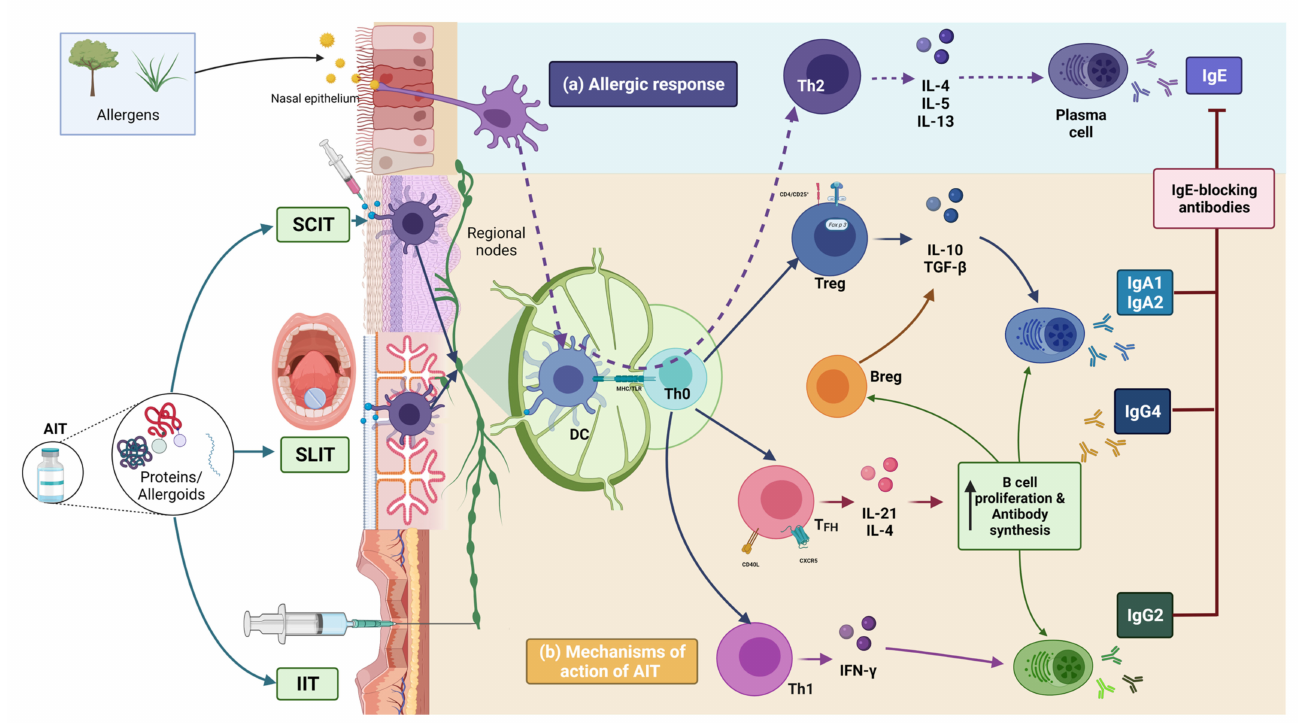
Figure 2. Mechanism of allergen-specific immunotherapy. ( a ) The allergic response begins with the allergen being endocytosed by the dendritic cells of the airway epithelium (DC). Subsequently, DC goes to local secondary lymphoid organs (lymph nodes) where the antigen presentation to Th0 happens. Th0 differentiate to Th2 and synthesize its interleukin profile to allow the production of IgE- type specific allergen antibodies. ( b ) Subcutaneous, sublingual, and intralymphatic immunotherapies (SCIT, SLIT, IIT) provides the antigen (peptide, recombinant, or protein complex) and induces T naive cells differentiation into different types, which synthesizes their interleukin profiles as Th1 (IFN- γ ) or Treg Foxp3 + (IL-10 and TGF- β ). TFH CXCR5 + (IL-21 and IL-4) profiles co-helping plasmatic cells